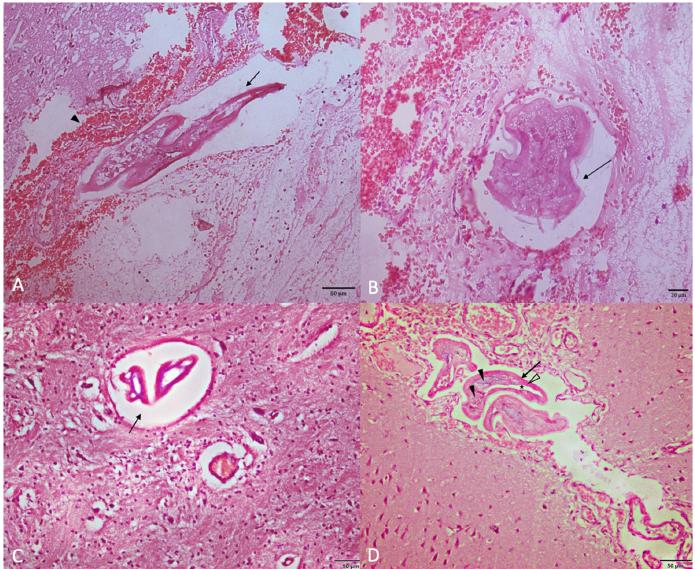
Figure 4. ( A ) Histological section of the brain stained with hematoxylin-eosin. Longitudinal aspect of nematodes (arrow) in the subarachnoid space of the diencephalon, associated with severe hem- orrhage (arrowhead). ( B ) Histological section of the brain stained with hematoxylin-eosin. Trans- verse aspect of a nematode inside a vessel in the subarachnoid space of the diencephalon (arrow). A severe hemorrhage around the vessel is evident. ( C ) Histological section of the brain stained with hematoxylin-eosin. Transverse aspect of nematodes inside of telencephalic brain vessels (arrow). ( D ) Histological section of a vessel in the subarachnoid space of the cerebral cortex, stained with hematoxylin-eosin. Cross sections of nematode with a thin cuticle (arrow), pseudocoelom (asterisk), celomatic musculature (empty arrowhead) and structures representing the internal organs of the parasite (arrowheads). At lungs gross examination, nematodes were found in the airways and identified as A. abstrusus according to morphological keys [17]. During the histological examination of the lungs, marked atelectasis and severe interstitial inflammatory infiltrate with a pre- dominance of lymphocytes and histiocytes were found. A typical appearance of the lung parenchyma compatible with aelurostrongylosis was observed [18], with the presence of eggs in a 3–8 cell stage in the alveolar lumen (Figure 5).